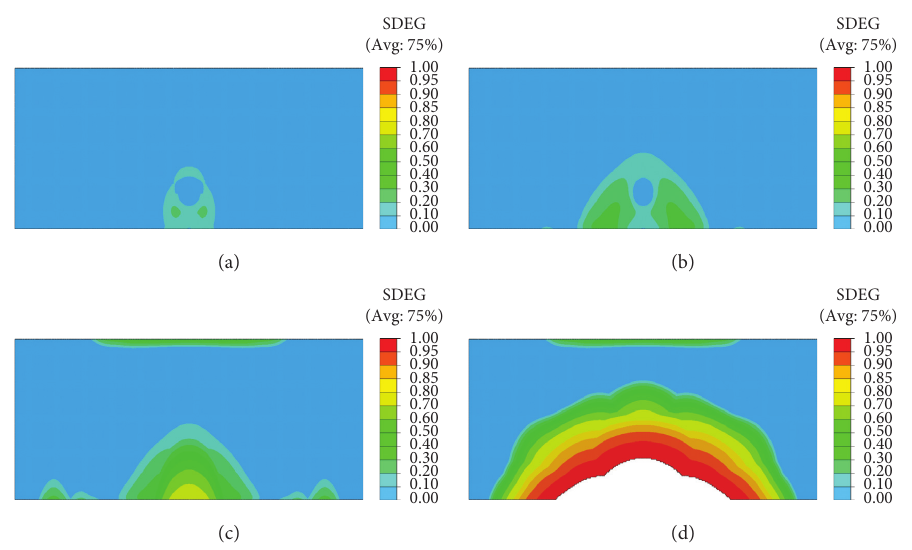
Figure 16: The evolution of the interfacial damage and delamination for selected moments. (a) Moment II. (b) Moment III. (c) The moment for the initiation of the interfacial tensile damage. (d) Moment IV.